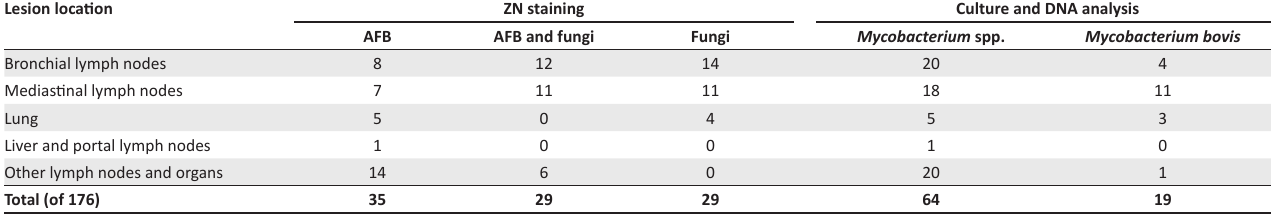
TABLE 1: Cause of granulomatous lesions recovered from slaughter cattle in Nairobi, Kenya, as detected according to direct acid-fast staining, culture and DNA typing. Lesion location ZN staining Culture and DNA analysis AFB AFB and fungi Fungi Mycobacterium